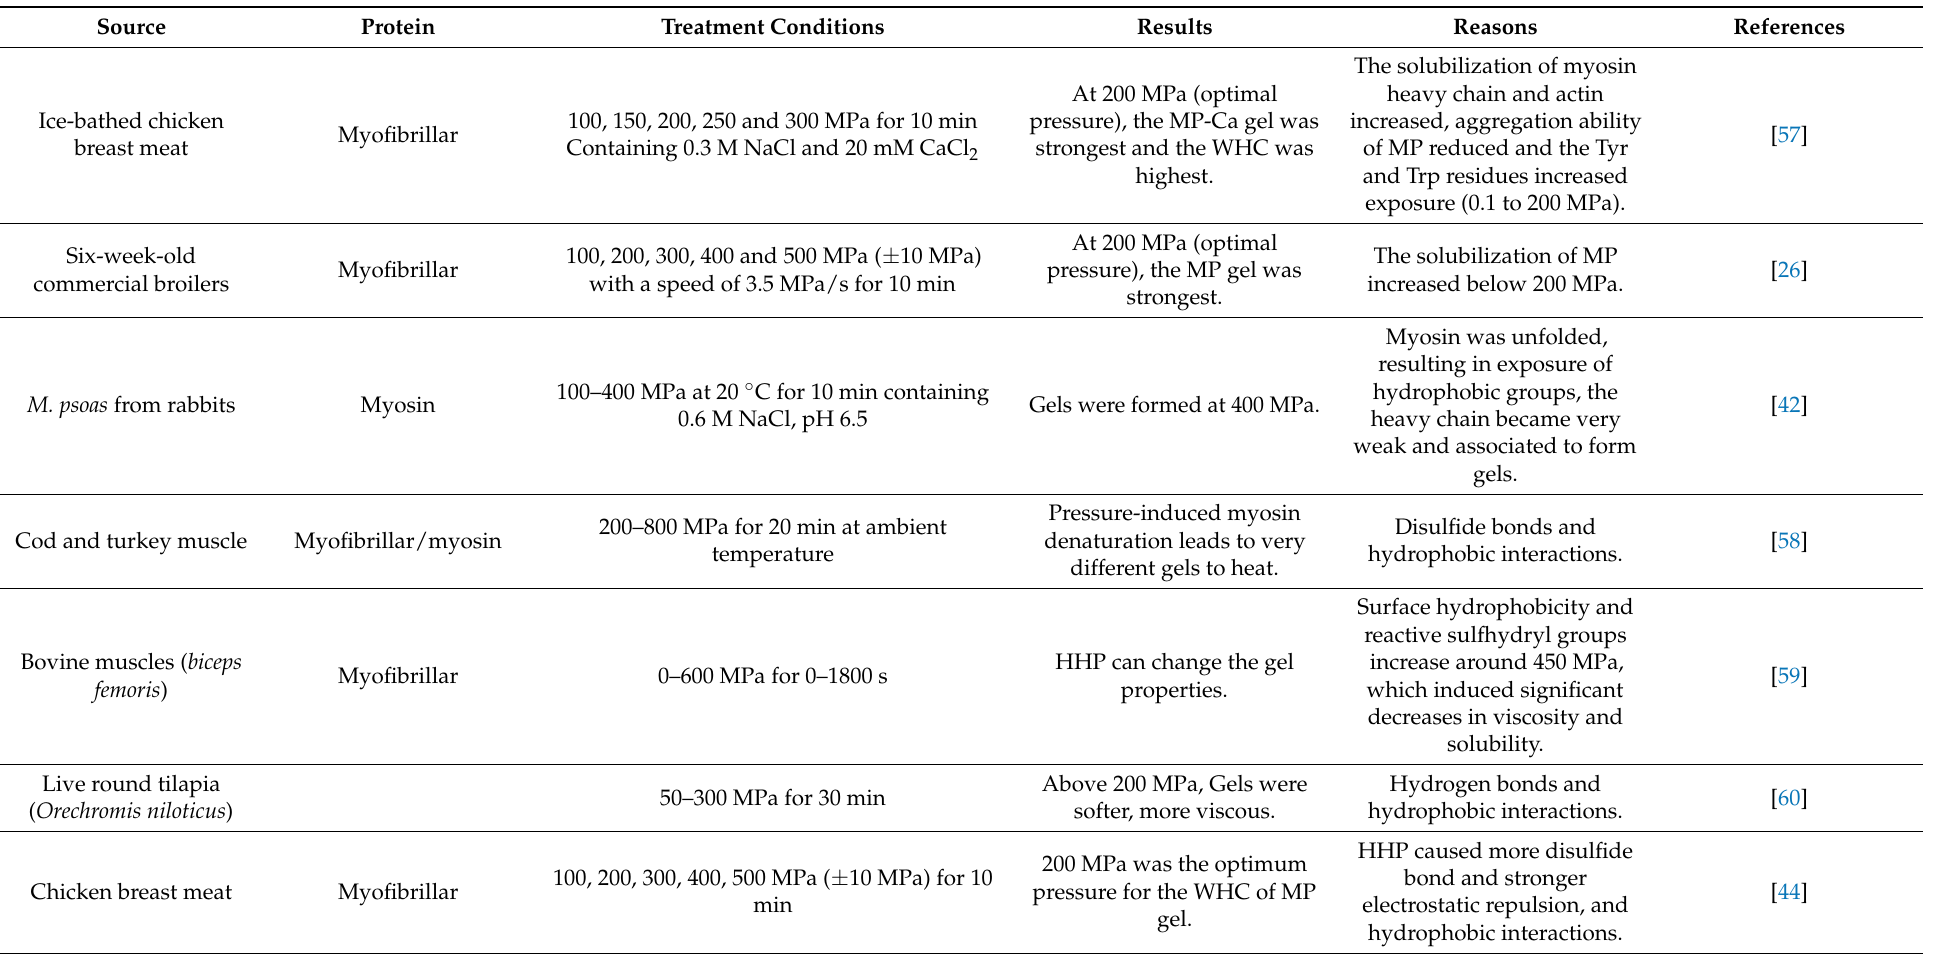
Table 2. Effects of HHP on myofibrillar